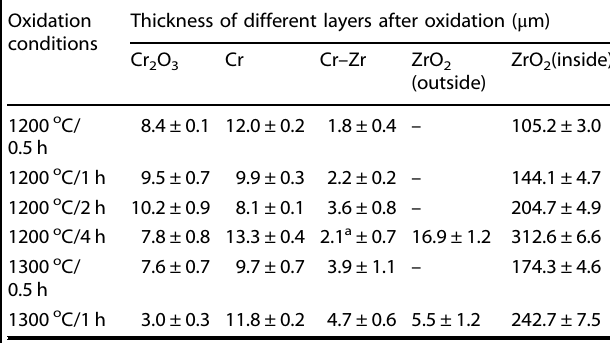
Table 1. Thickness of different layers of the Cr-coated tubes after